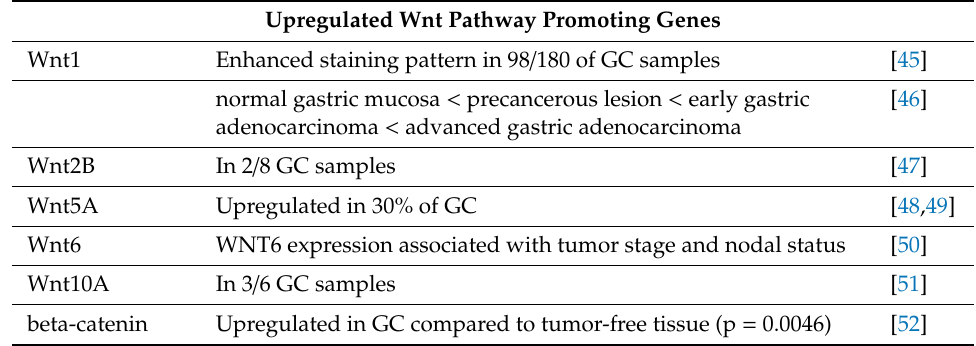
Table 1. Overview of Wnt pathway components dysregulated in the context of gastric cancer